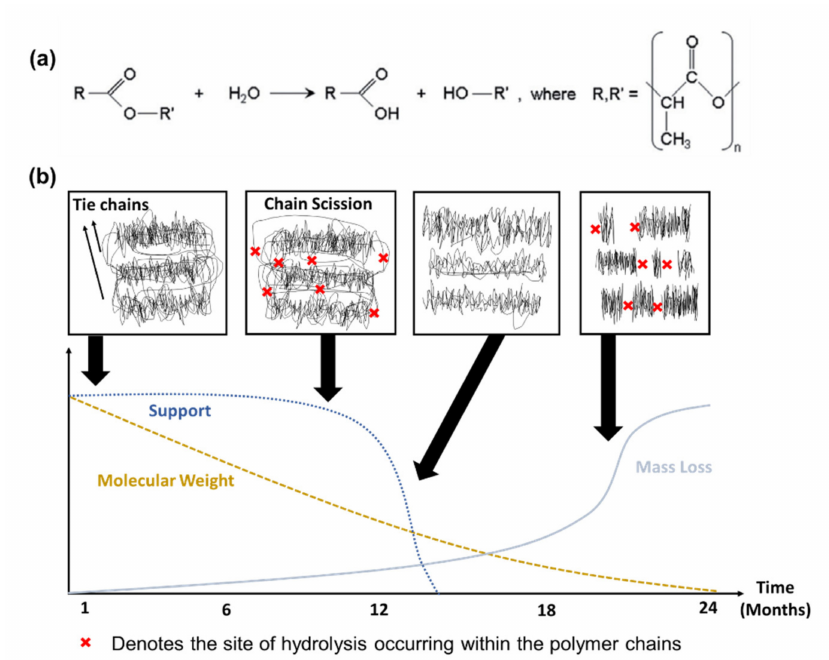
Figure 1. Degradation of aliphatic polylactic acid (PLA). ( a ) Hydrolysis of ester bond. ( b ) Illustration of the loss of device’s radial strength (starts at 6 months), loss of mass (12 months) and molecular weight with time. The complete degradation of BRS is expected to be at 24 months mark [35]. Image adapted from